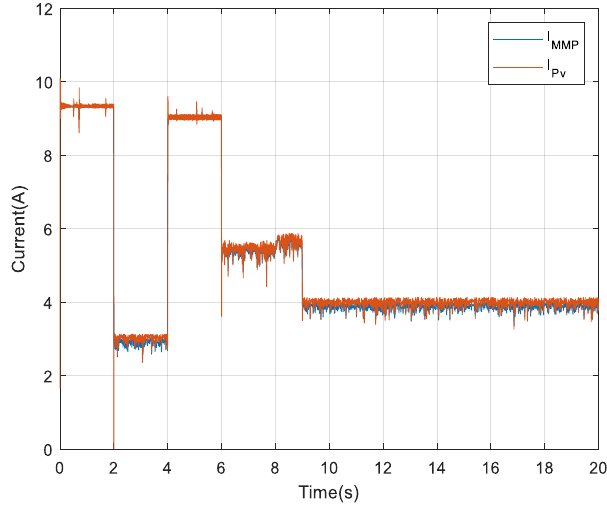
Figure 23. Temporal evolution of PV current over time.